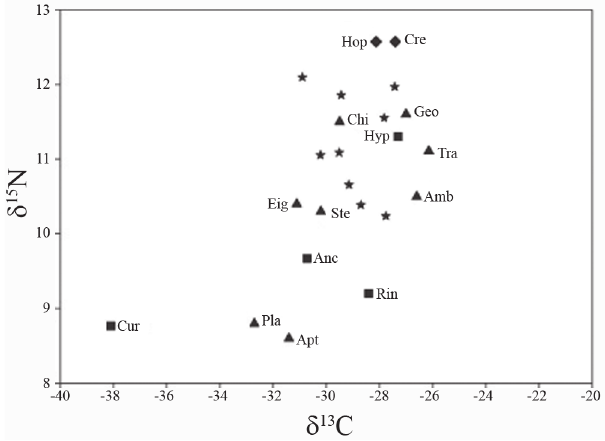
Fig. 2. Scatter plot of δ 13 C and δ 15 N signatures for Arapaima and prey fish. The plot includes points for individual Arapaima (stars) and mean for values of prey taxa when possible (diamonds = piscivores, n = 6, triangles = omnivores, n = 12, squares = detritivores, n = 10). Species names for prey fishes are: Amb = Amblydoras sp., Anc = Ancistrus sp., Apt = Apteronotus cf. albifrons , Ch = Chilodus sp., Cre = Crenicichla sp., Cur = curimatid, Eig = Eigenmannia sp., Geo = Geophagus surinamensis , Hop = Hoplias malabaricus , Hyp = Hypostomus sp., Pla = Platydoras sp., Rin = Rineloricaria sp., Ste = Sternopygus sp., Tra = Trachycorystes trachcorystes